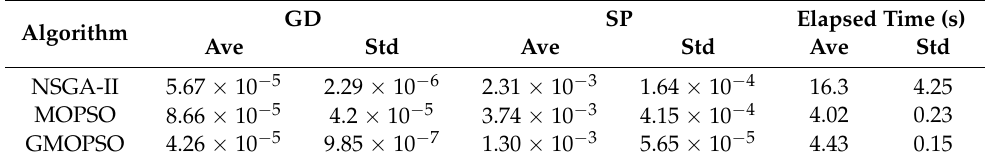
Table 4. Performance comparison for NSGA-II, MOPSO and GMOPSO in test function ZDT2.